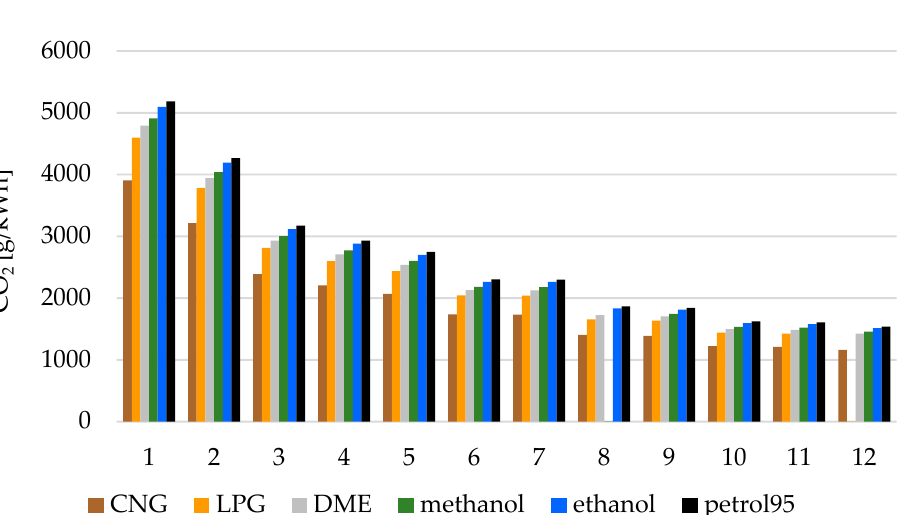
Figure 15. A Summary of carbon dioxide emissions in the tests per one kilowatt hour: 1—Random Cycle High ( × 95); 2—NEDC; 3—US SC03; 4—CADC wo mot; 5—Random Cycle Low ( × 05); 6—WLTC 3b random; 7—FTP-75; 8—CADC; 9—US 06; 10—CADC shortened; 11—MAC TP cycle; 12—US highway.